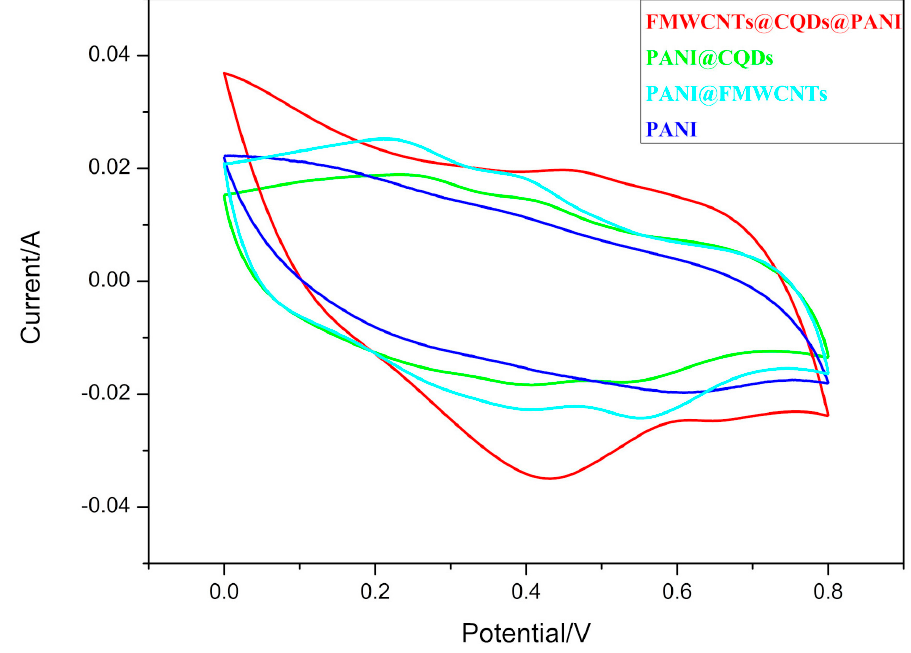
Figure 5. Cyclic voltammetry curves of PANI, PANI @ CQDs, PANI @ FMWCNTs and FMWCNTs @ CQDs @ PANI.